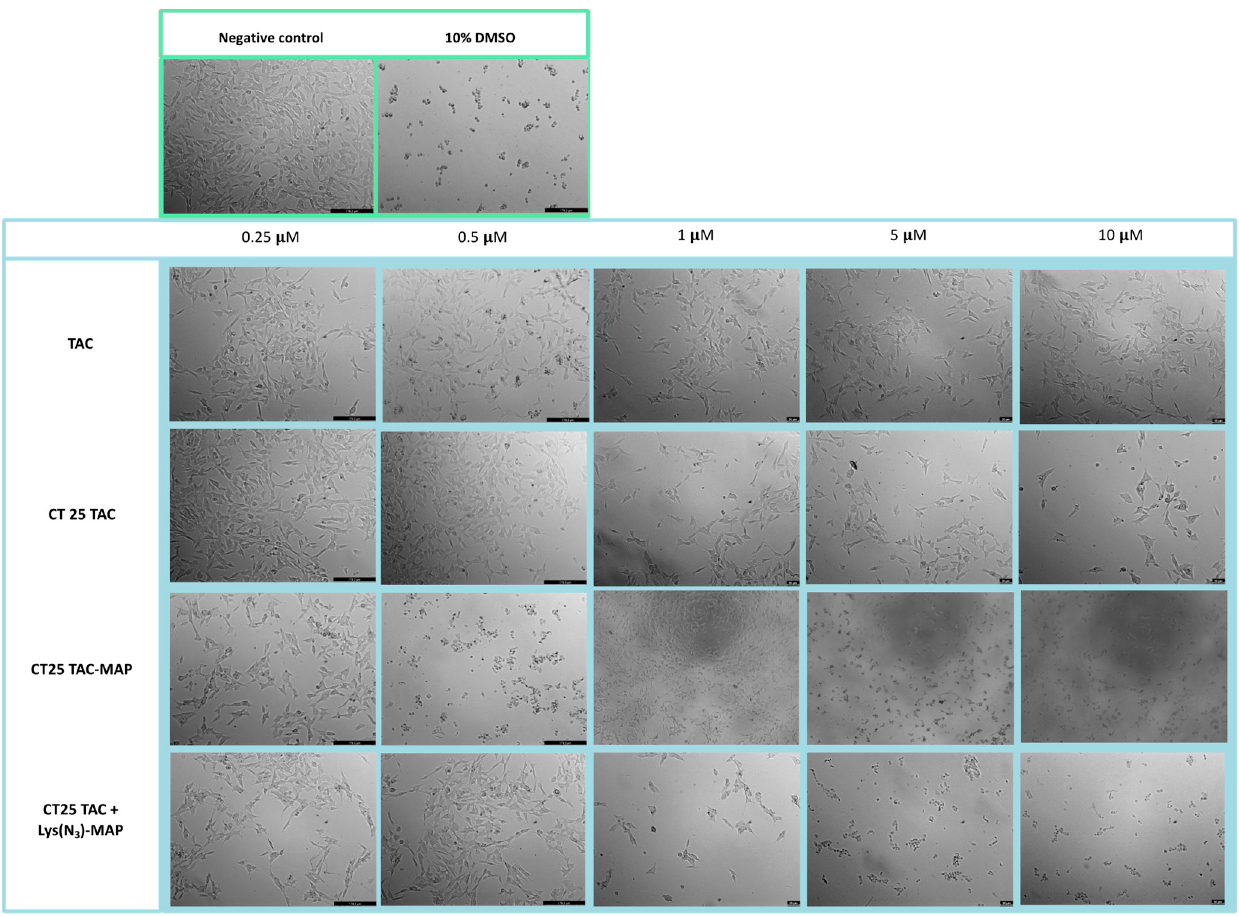
Figure 16. Microscope cellular visualization through Lionheart FX and Leica DFC350 FX of treatment with negative control (H 2 O), positive control (10% DMSO), free drug and NLC-loaded formulations (CT25TAC, CT25TAC-MAP and CT25 TAC + Lys(N 3 )-MAP) on SH-SY5Y cell line at a concentration of 0.25, 0.5, 1, 5 and 10 μ M.